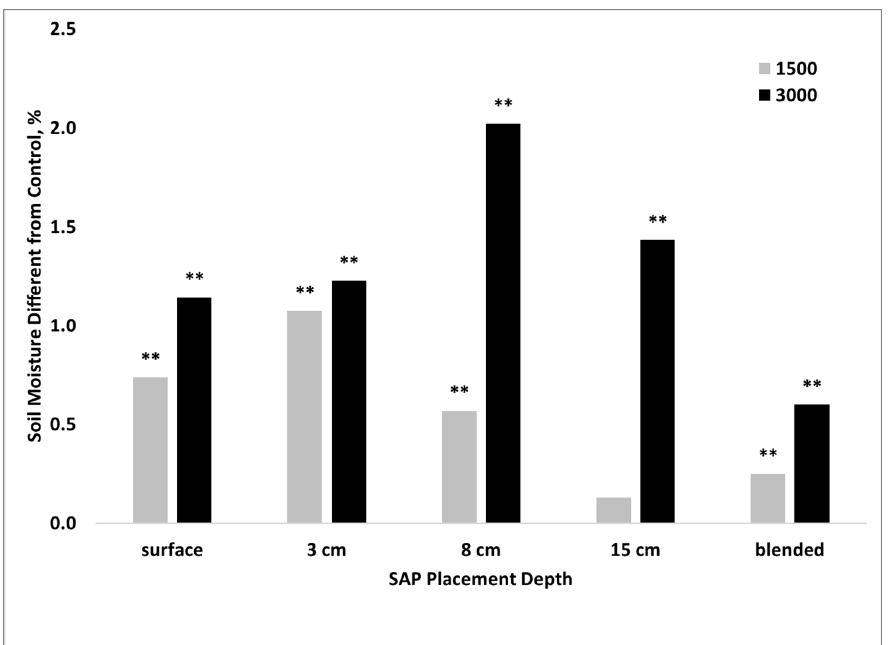
Figure 2. Soil moisture as a function of a superabsorbent polymer (SAP) rate and placement relative to an untreated control averaged across 108 d of a glasshouse study with bottlebrush squirreltail. The SAP (1500 or 3000 kg ha − 1 ) was blended with the soil to a depth of 15 cm or placed in a band at the surface or at 3, 8, or 15 cm deep directly below the seed. The soil was then saturated and allowed to dry down. Bars marked with “**” were highly significant at p < 0.0001.